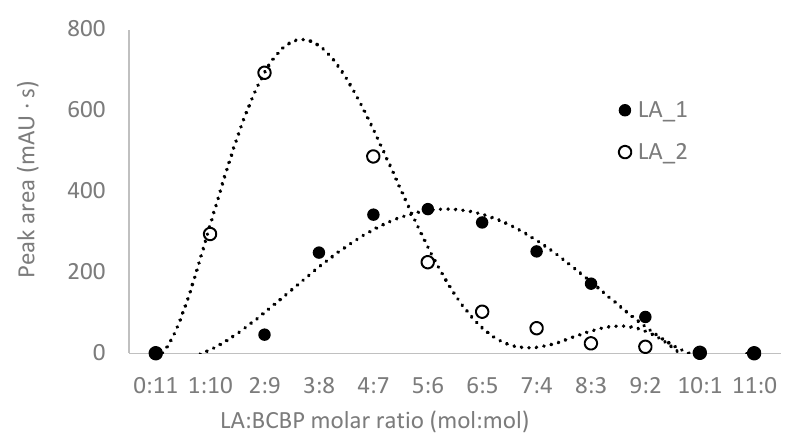
Figure 3. Estimation of stoichiometric molar ratio by continuous variation method for the reaction of α -lipoic acid with 1-benzyl-2-chloropyridinium bromide. The reaction was carried out in 0.2 mol·L − 1 , phosphate buffer, pH = 9.